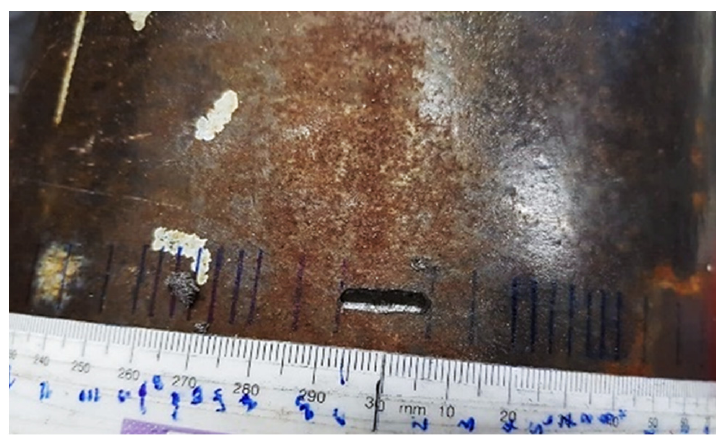
Figure 8. A 0.2 λ SH0 long circumferential notch used in the experiments.